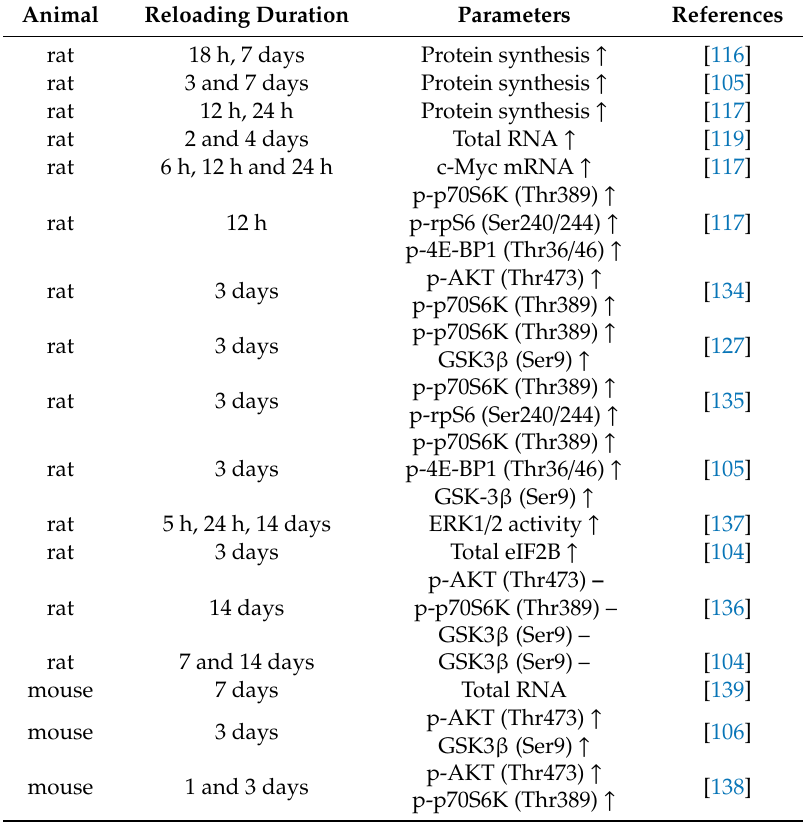
Table 1. The e ff ect of reloading after mechanical unloading on the key anabolic markers in rodent soleus